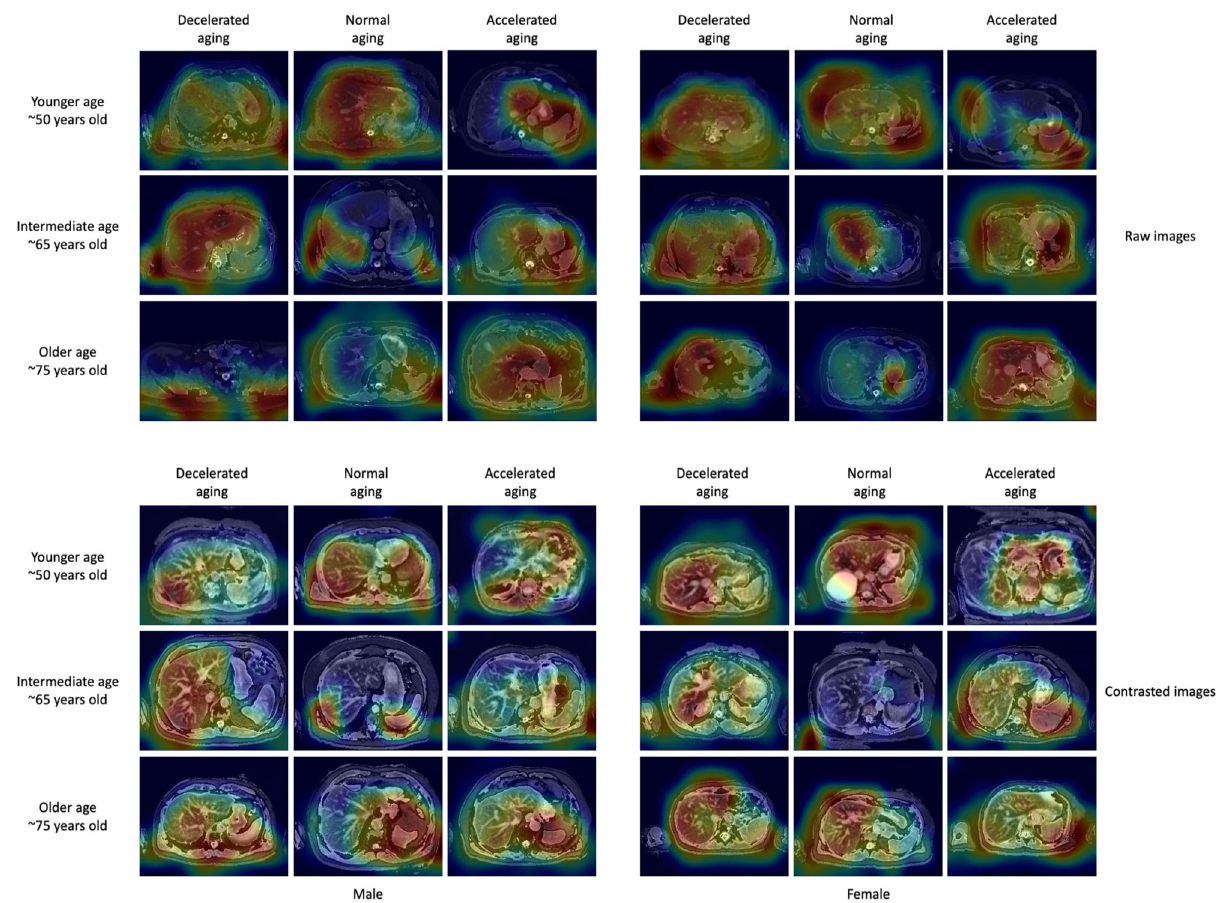
Fig. 3 Sample attention maps for liver MRI-based models on raw and contrasted images. “ Warm ” fi lter colors (more red) highlight regions of high importance according to the Grad-RAM map. Actual chronological ages are